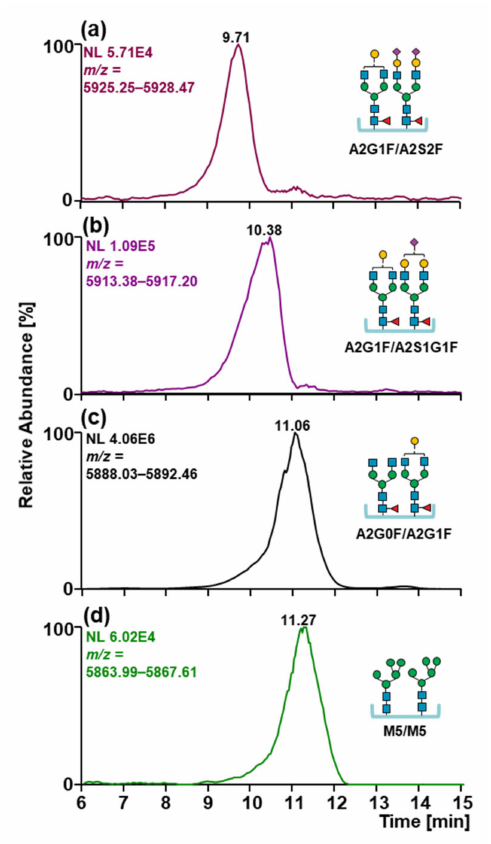
Figure 6. Extracted ion current chromatograms of the most abundant charge state of the glycoform sialic acids eluted at lower RT while oligomannose type to higher RT. Glycan structures, names, and compositions are collected in Table